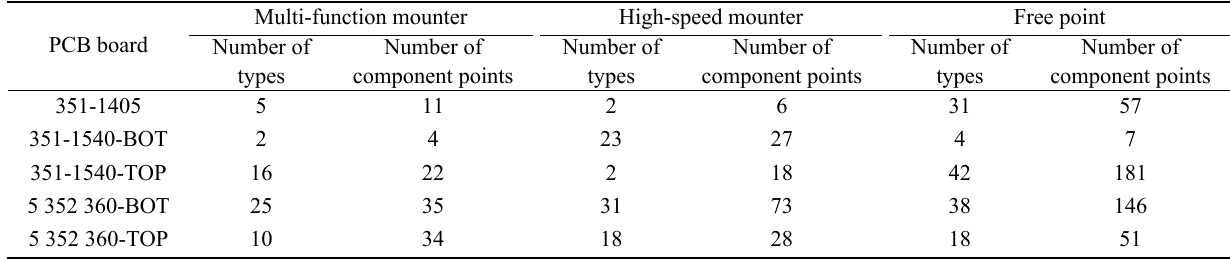
Table 3 Component mount limit